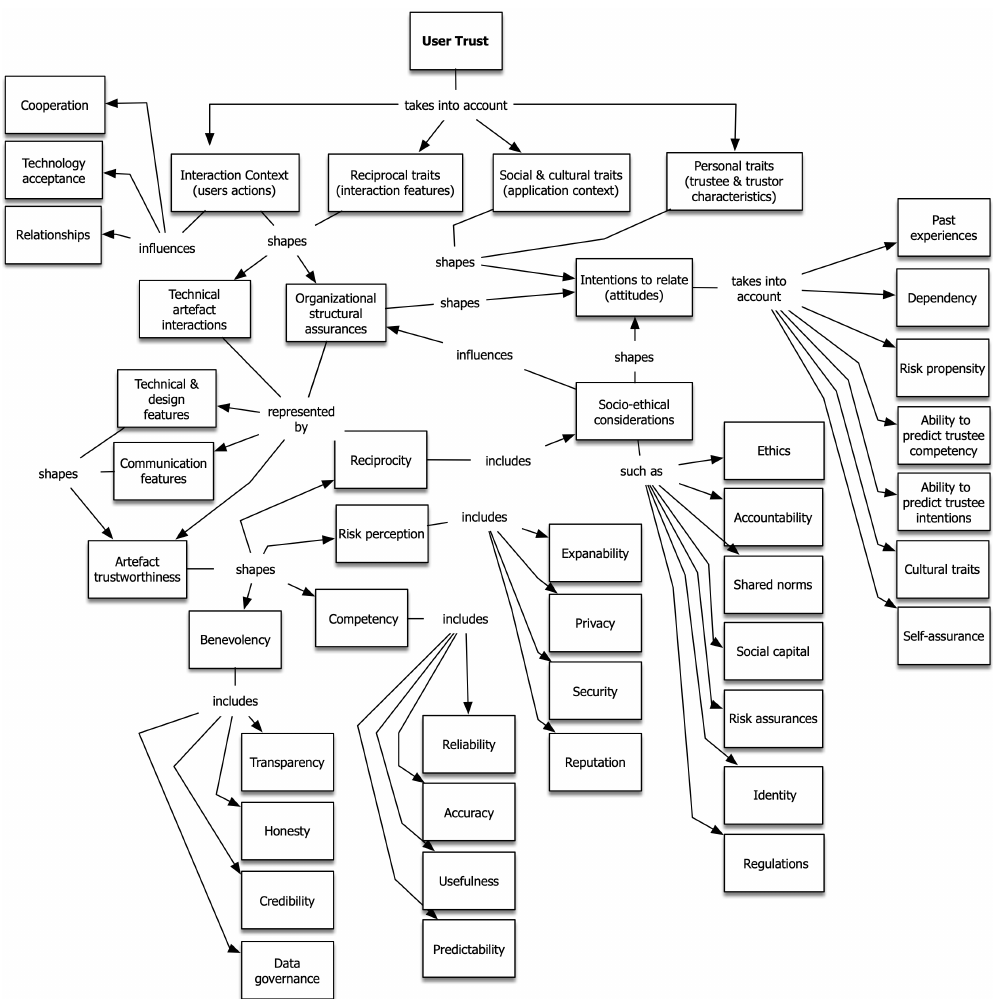
Figure 2. The user trust influence in shaping the interaction context: